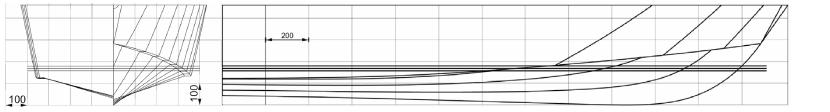
Figure 1. NSS parent hull body plan and buttock lines. Table 1. Hulls